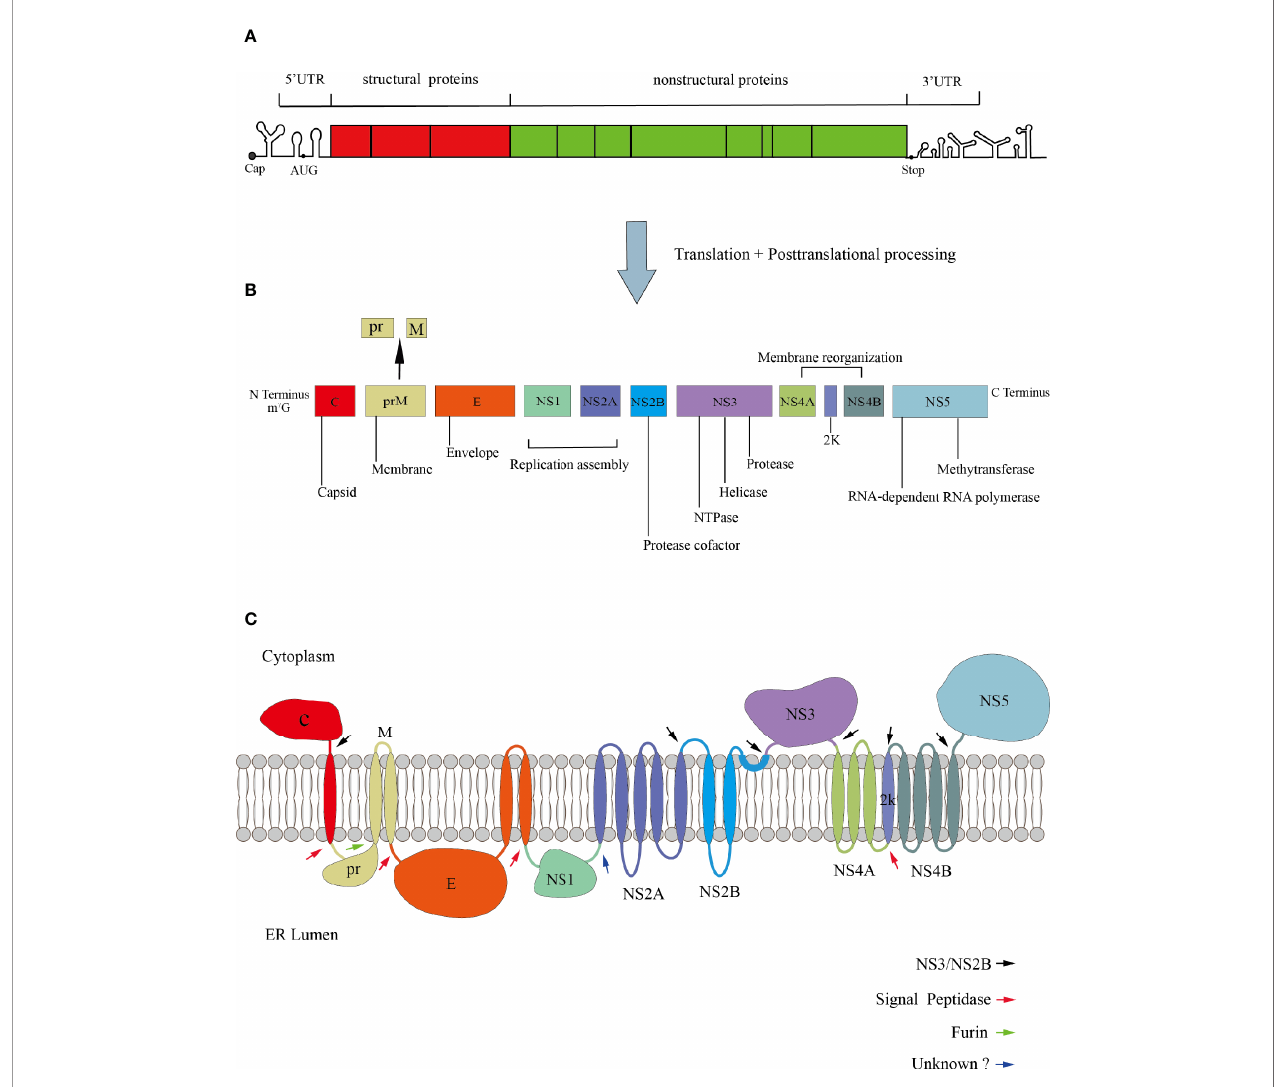
FIGURE 1 | Genomic organization of Flavivirus. (A) The genome is divided into UTR and ORF. (B) The ORF encodes three structural proteins, seven non-structural proteins, and a signal peptide 2K with 17 amino acids. (C) Polyprotein membrane topology. The black arrows indicate the cleavage site of the viral protease NS3/ NS2B. The red arrows denote the cleavage site of the host signal peptidase. The green arrow indicates the cleavage of prM to M and pr. The blue arrow denotes the cleavage site of an unknown host